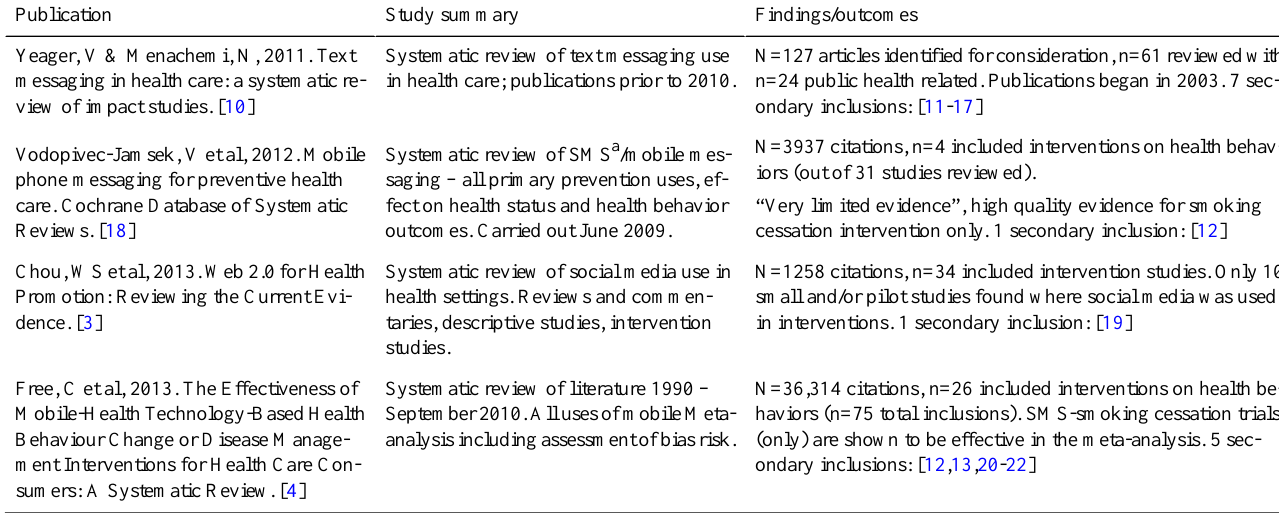
Table 1. Summary of general relevance